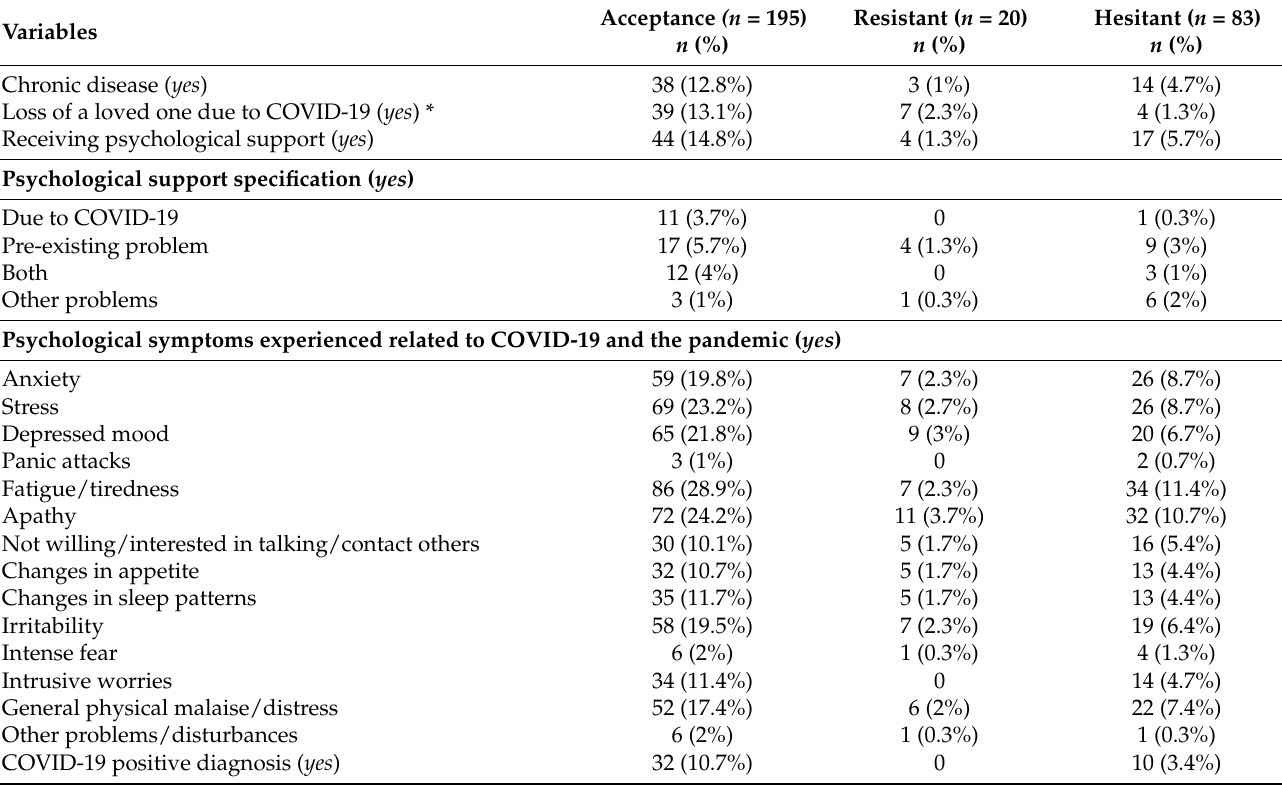
Table 2. Clinical and COVID-19 related data ( N = 300) a .